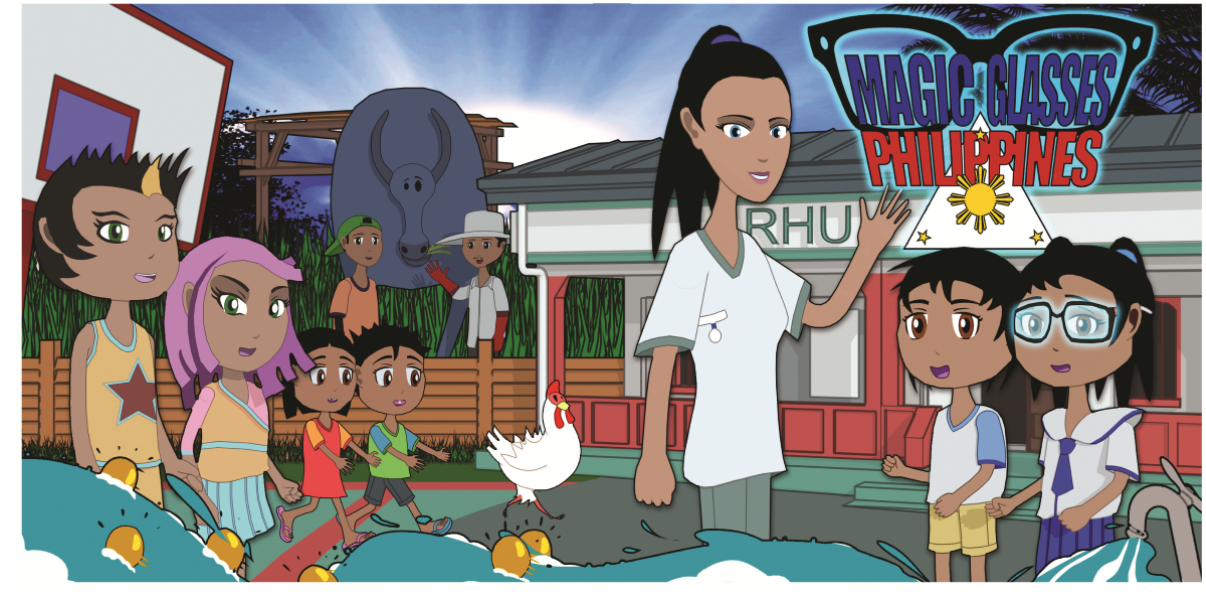
Figure 2. Cover of the cartoon “The Magic Glasses